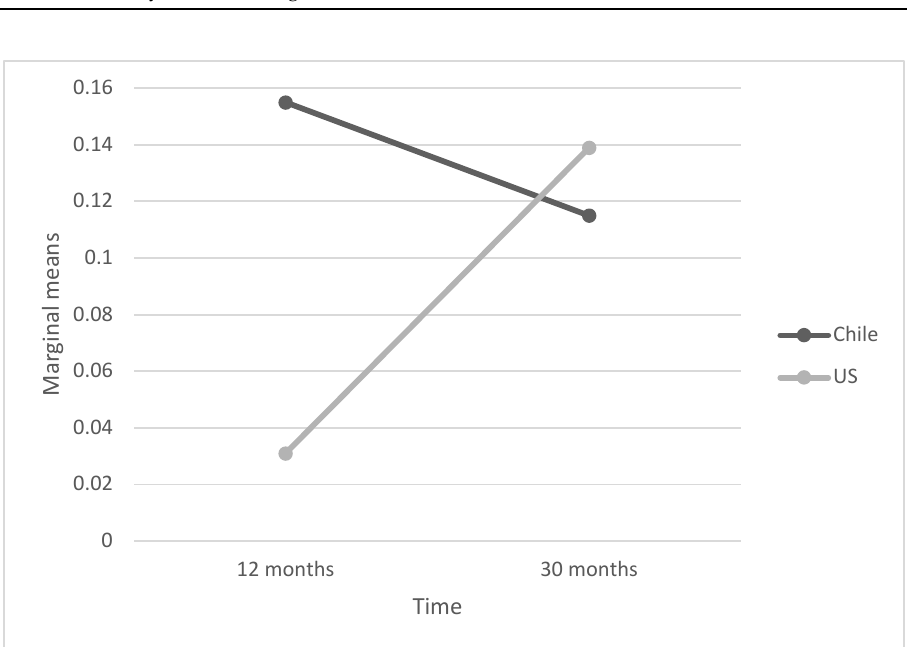
Figure 3. Distribution of marginal means of mothers’ regulatory talk considering time and country.